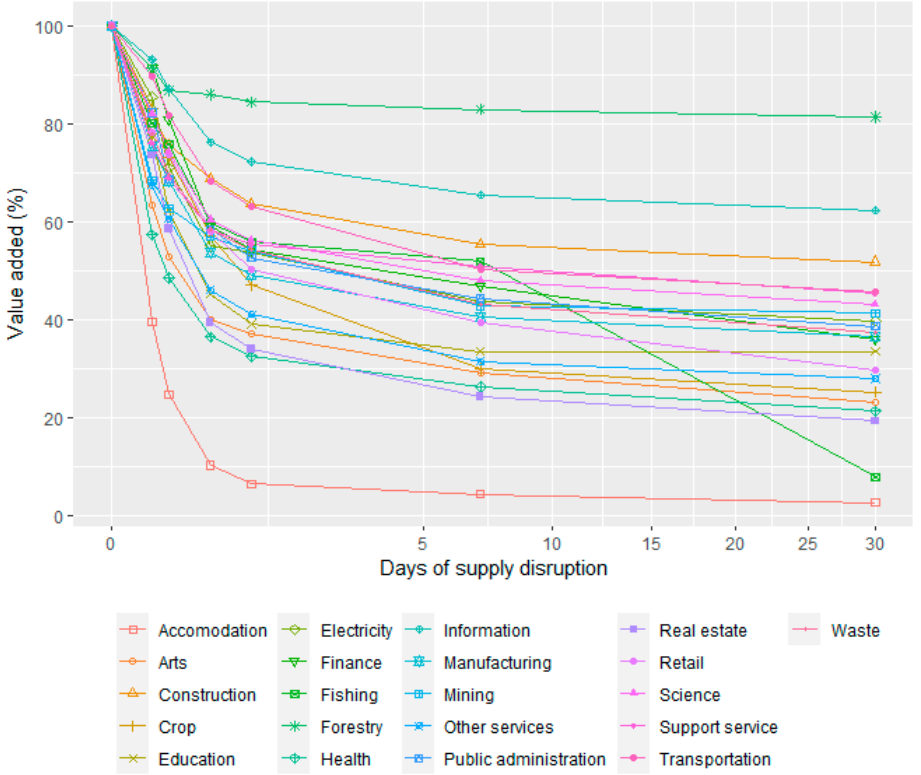
Figure 3. Maintained value added for the non-manufacturing sectors, expressed as a percentage of normal business activity during water supply disruptions of different durations.